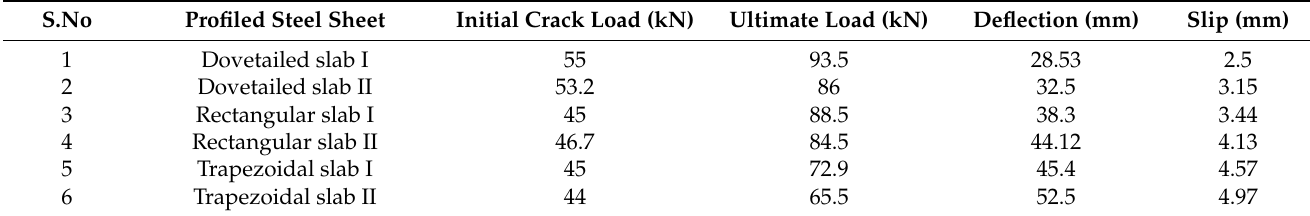
Table 4. Test results of composite deck slabs.